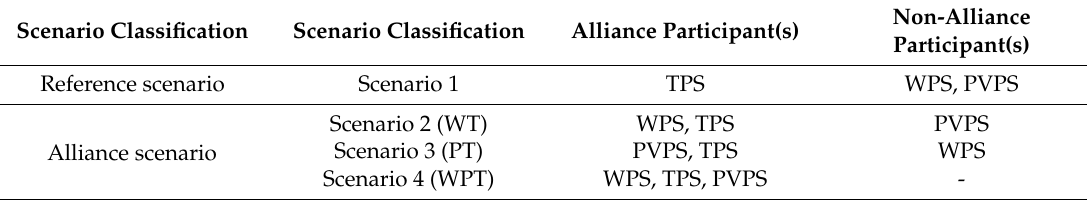
Table 2. Scenario